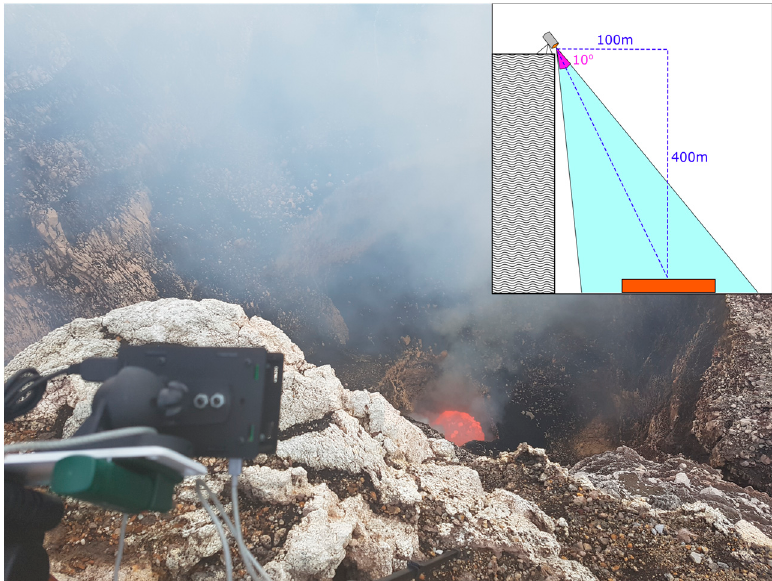
Figure 2. Main image: Photograph of the PiCam capturing images of the lava lake at Masaya volcano on 12 June 2017. The plume aerosols are quite clearly visible, as are bubble bursts in the lake itself. Inset: A schematic of the estimated viewing geometry provided by Instituto Nicaragüense de Estudios Territoriales (INETER; Personal Communication, 2017); figure not to scale.